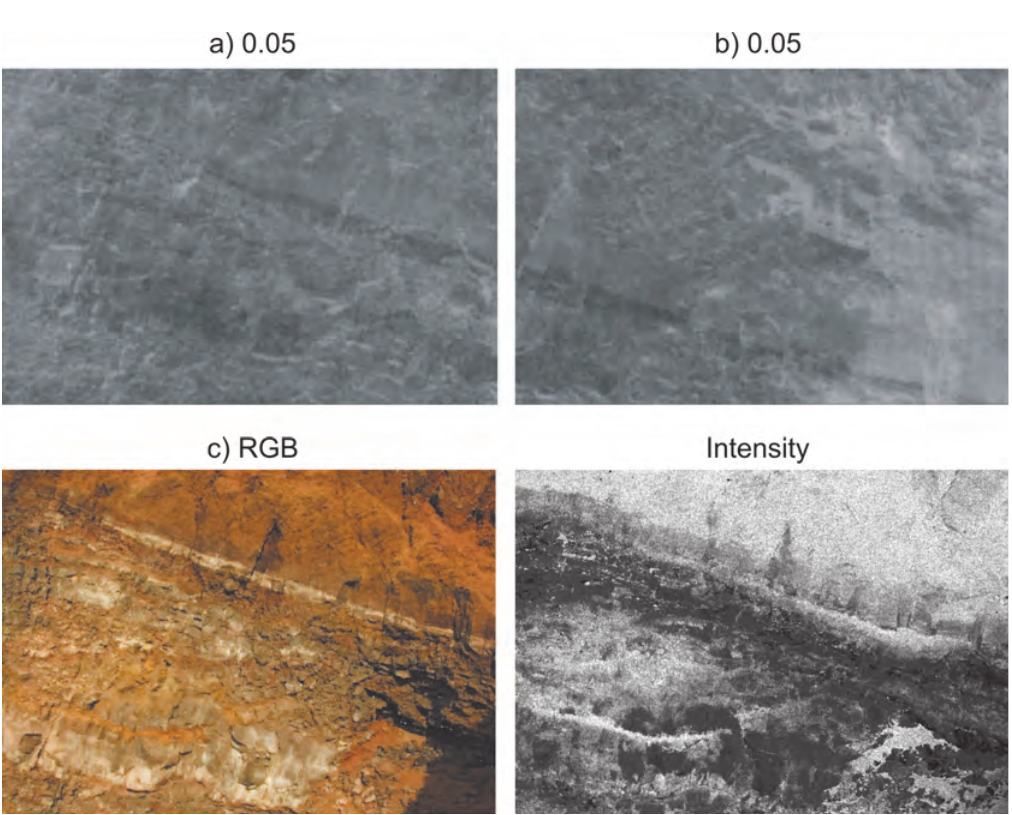
Fig. B2. Principal component analysis of R channel of the RGB image and TLS-based intensity: original R chan- nel (a); intensity (b), principal component having the largest variance (c,d). Note that on this PC, which is the only output component if the 0.3 limit-variance is considered, contains information related to both the vectors, shows features that can be easily